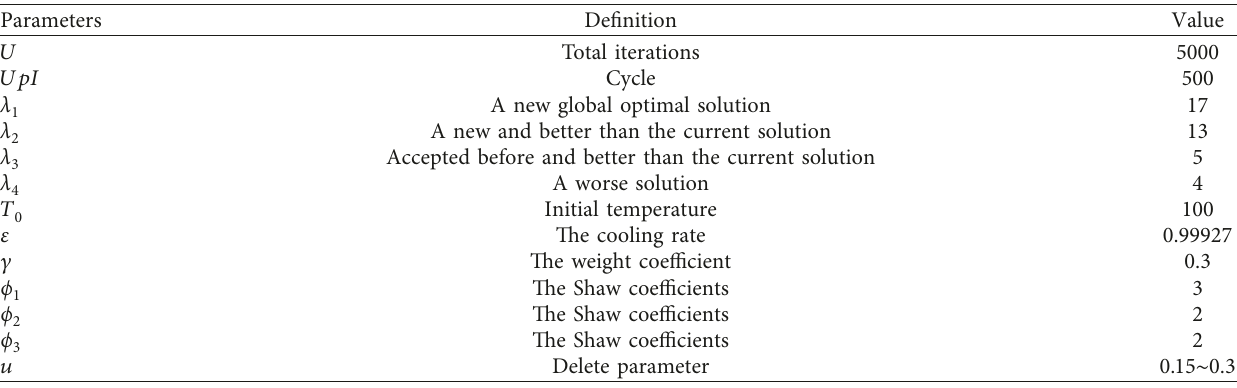
Table 2: Parameters used in ALNS